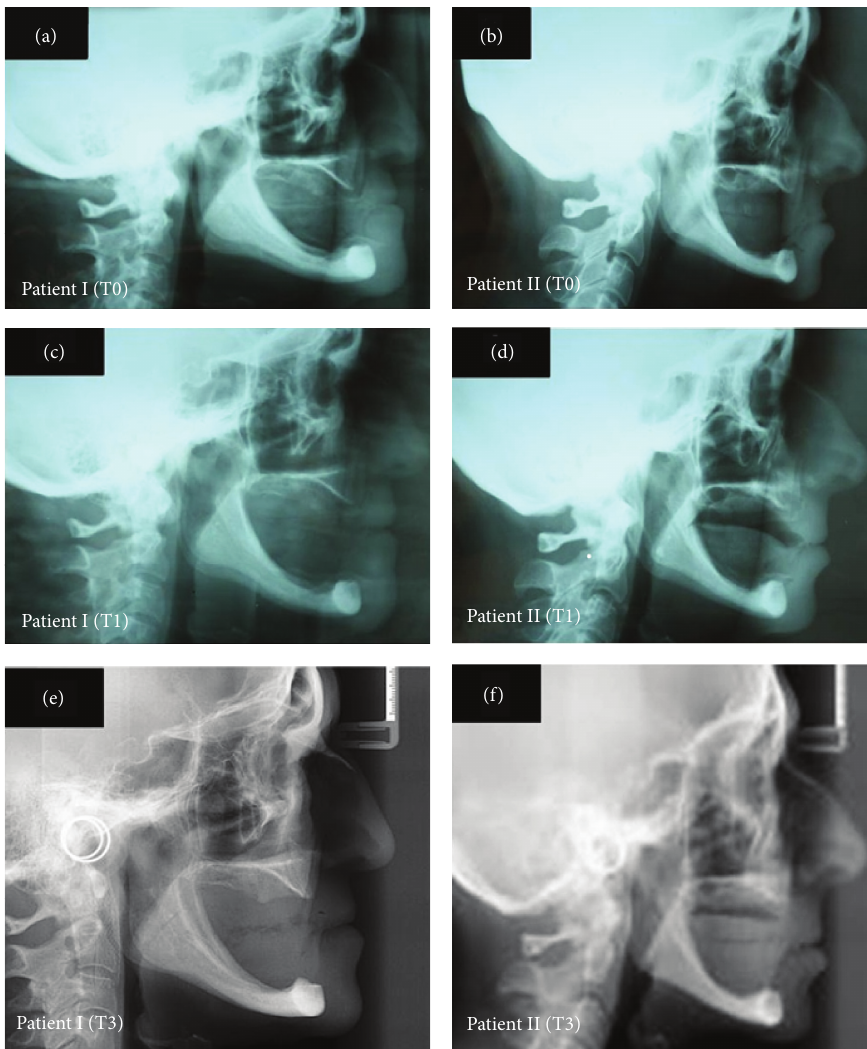
Figure 2: Lateral cephalometric radiograph of patients. (a) Patient I at baseline or T0. (b) Patient II at baseline or T0. (c) Patient I at trial insertion or T1. (d) Patient II at trial insertion or T1. (e) Patient I after four years of rehabilitation or T3. (f) Patient II after four years of rehabilitation or